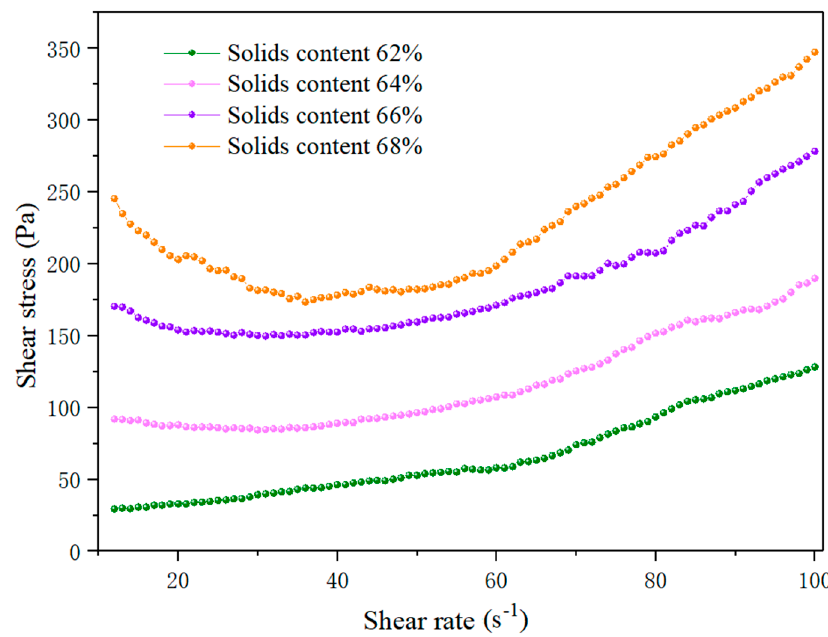
Figure 4. Shear rate versus shear stress flow curves of UCPB. Table 4. Fitting equation parameters of UCPB.